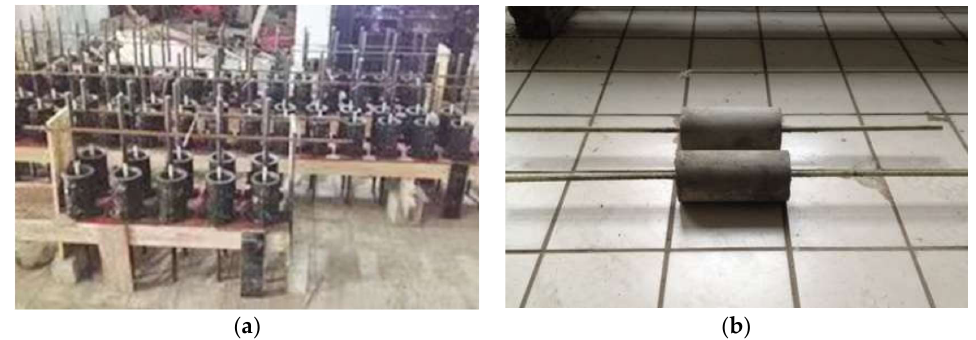
Figure 2. Fabrication of concrete specimens with GFRP bars: ( a ) Molds secured in place; ( b ) Concrete specimens with GFRP bars.